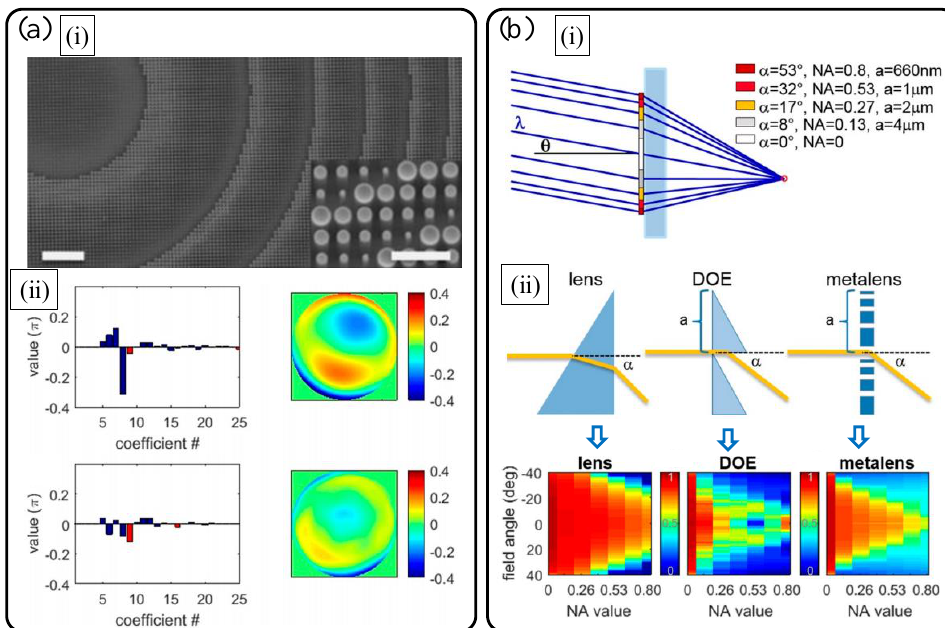
Figure 4. Performance limits of a flat hyperbolic TiO 2 dielectric metalens [16]. ( a ) ( i ) Scanning electron micrographs and ( ii ) on-axis wavefront aberration comparison of polarization insensitive hyperbolic metalens (lower plots) with reference objective lens (upper plots) with the same NA of 0.8. The two scale bars in ( i ) are 5 µ m ( left ) and 1 µ m ( right ), respectively. In ( ii ), left and right plots are Zernike aberration coefficients with the Fringe notation (red: spherical aberrations) and normalized wavefront error function maps, respectively. ( b ) Field and wavelength-dependent focusing efficiency: comparison of the hyperbolic metalens with refractive and diffractive lenses. ( i ) Simulation scheme and ( ii ) simulated deflection efficiencies of refractive, diffractive, and metasurface lenses according to field angle. ( a , b ) Reprinted with permission from [16]. Copyright 2019 American Chemical Society.